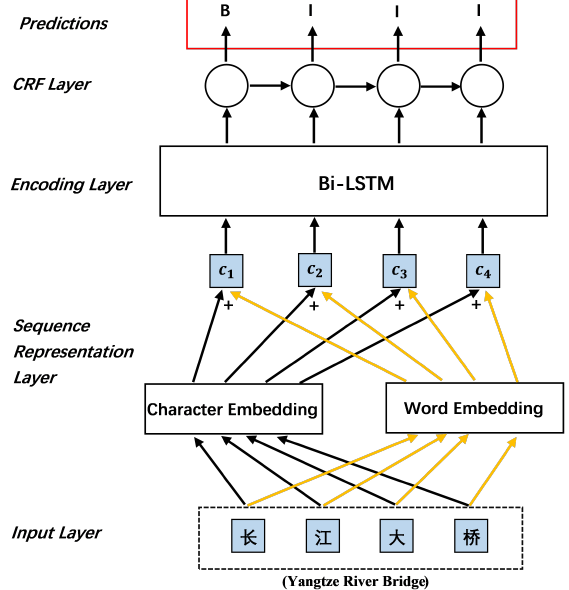
Figure 4. The overall architecture of the SoftLexicon+Bi-LSTM-CRF model. (The SoftLexicon method is used to generate word embedding at the sequence representation layer of the